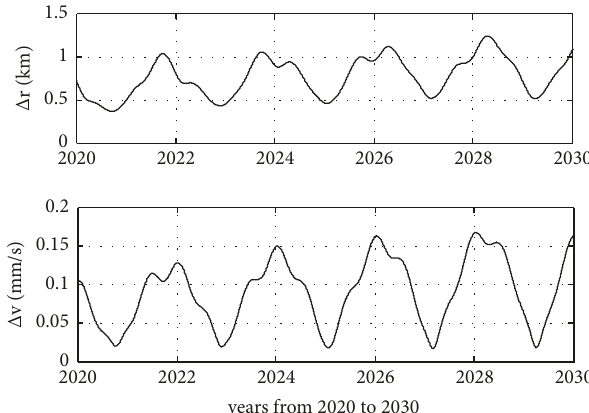
Figure 1: The difference on relative positions and velocities of Mars and earth between DE421 and